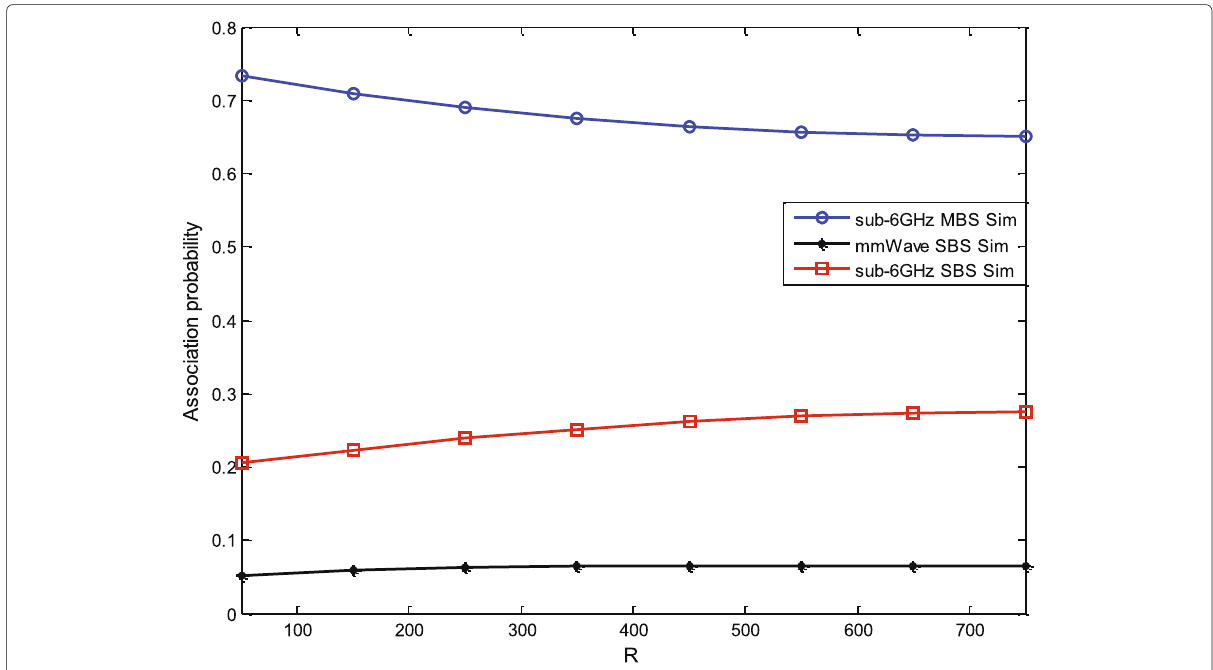
Fig. 8 Association probability vs. the cluster radius